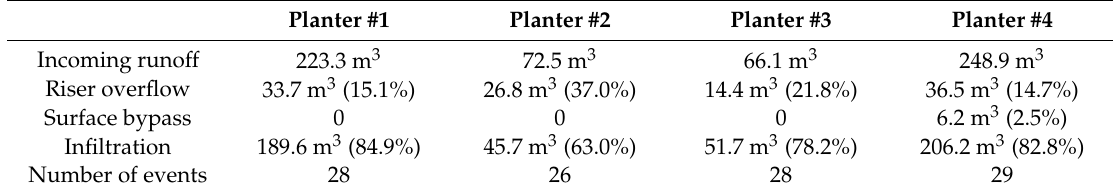
Table 2. Summary of incoming runo ff , overflow, and infiltration for the planters during the period of